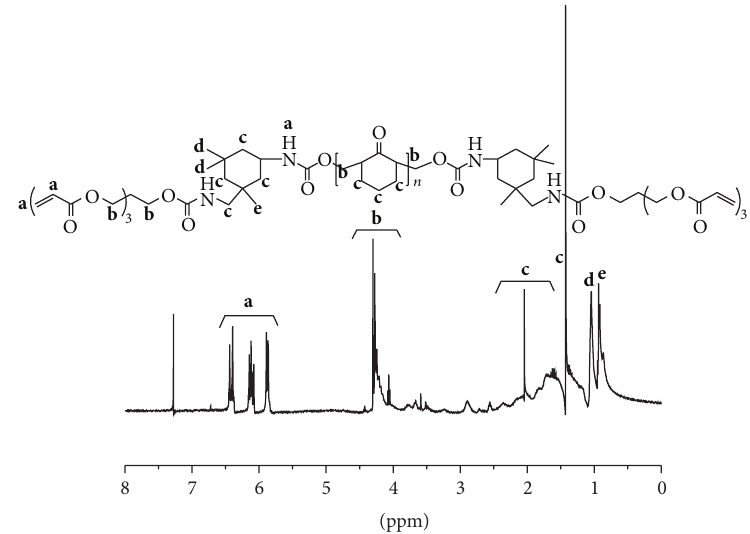
Figure 3: 1 H-NMR spectrum of UVCF resin.